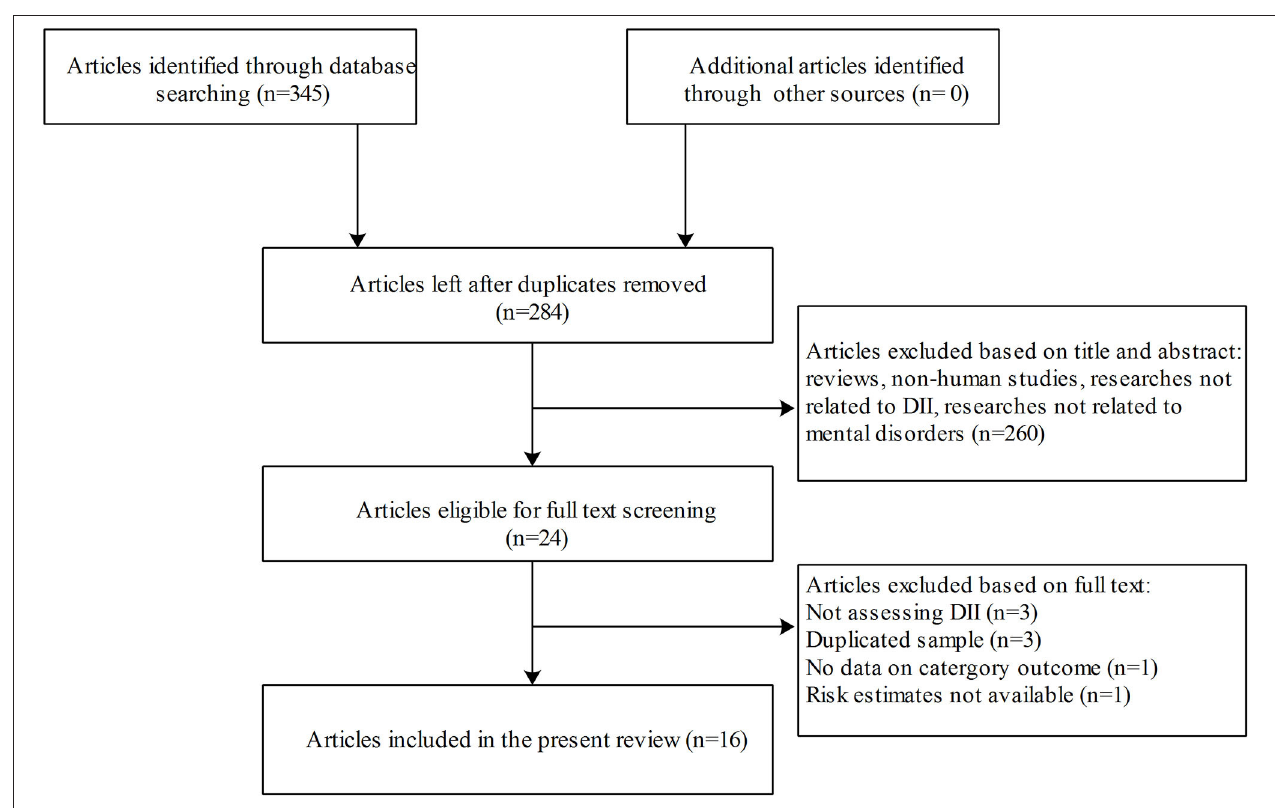
FIGURE 1 | Flowchart for study selection